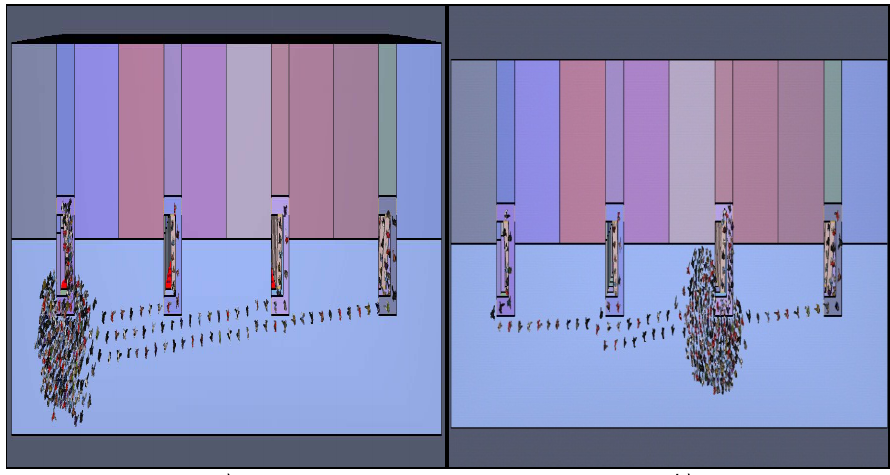
Figure 5 – Simulation scene for the fourth scenario where the fourth entrance/exit was opened while other entrances/exits were blocked, the elevators enabled and for the occupants’ speeds of 0.75 m/s (a) and a simulation scene for the fourth scenario where the second entrance/exit was opened while other entrances/exits were blocked, the elevators disabled and for the occupants’ speeds of 1.75 m/s